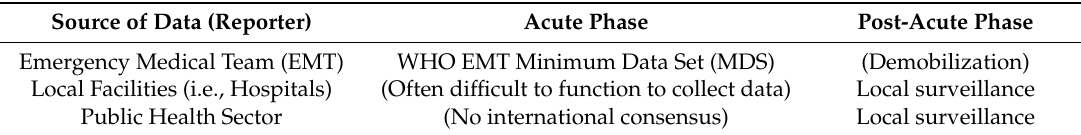
Table 1. Source and available tools or methods for health data collection during and after emergencies and